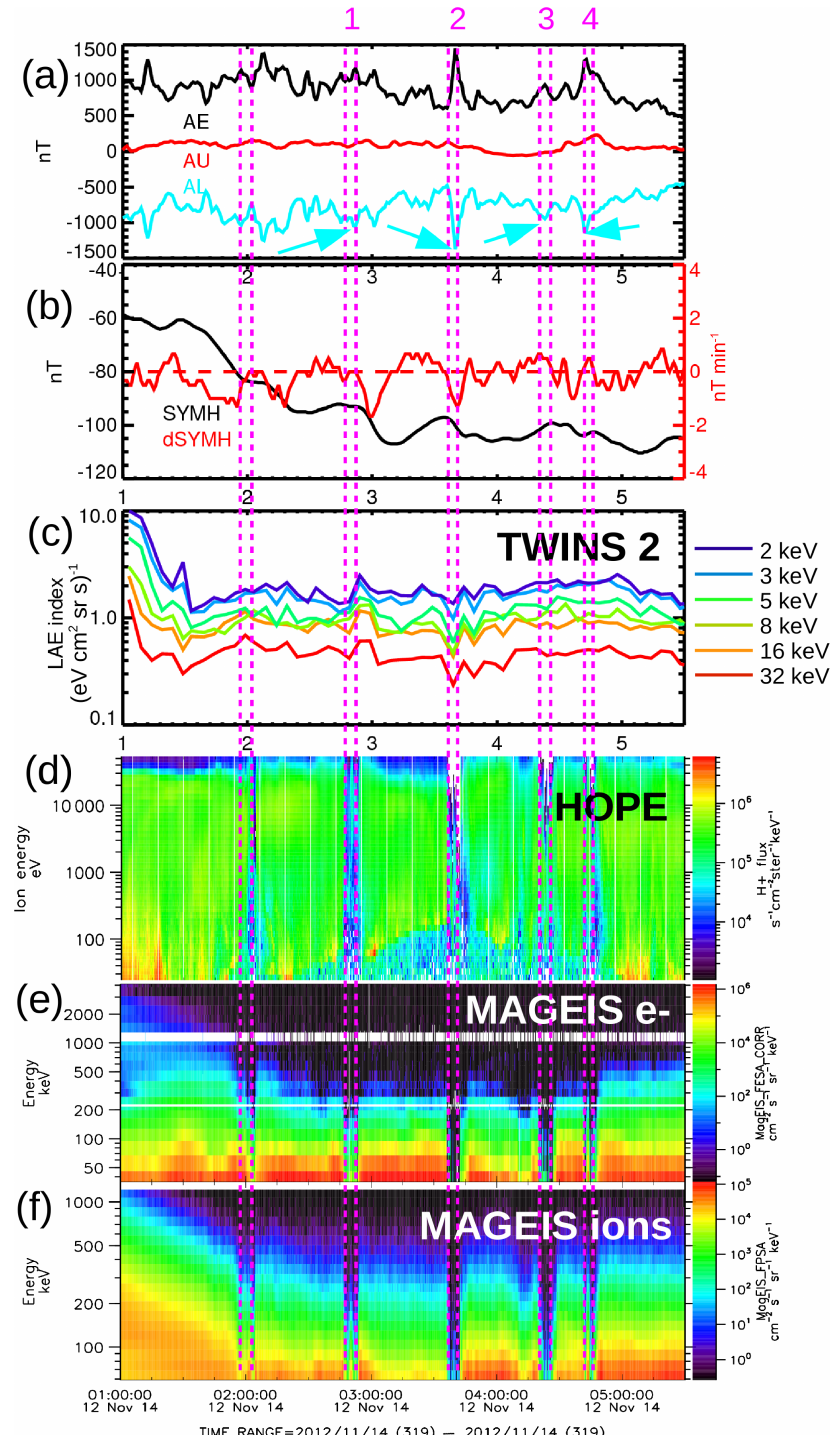
Figure 1. Overview of the dropout event for 14 November 2012. (a) Kyoto geomagnetic indices AE, AU, and AL; (b) Kyoto geomagnetic index SYMH and derived dSYMH; (c) TWINS 2 low-altitude emissions (LAEs) ENA index for multiple energy bands; (d) Probe A omni- directional HOPE H + fluxes in the energy range 20eV–50keV; (e) Probe A omnidirectional MAGEIS electron fluxes in the energy range 40keV–4MeV; (f) Probe A omnidirectional MAGEIS ion fluxes in the energy range 50keV–2MeV. The dropouts are marked by magenta lines. For the rest of the paper we will concentrate on the dropouts marked